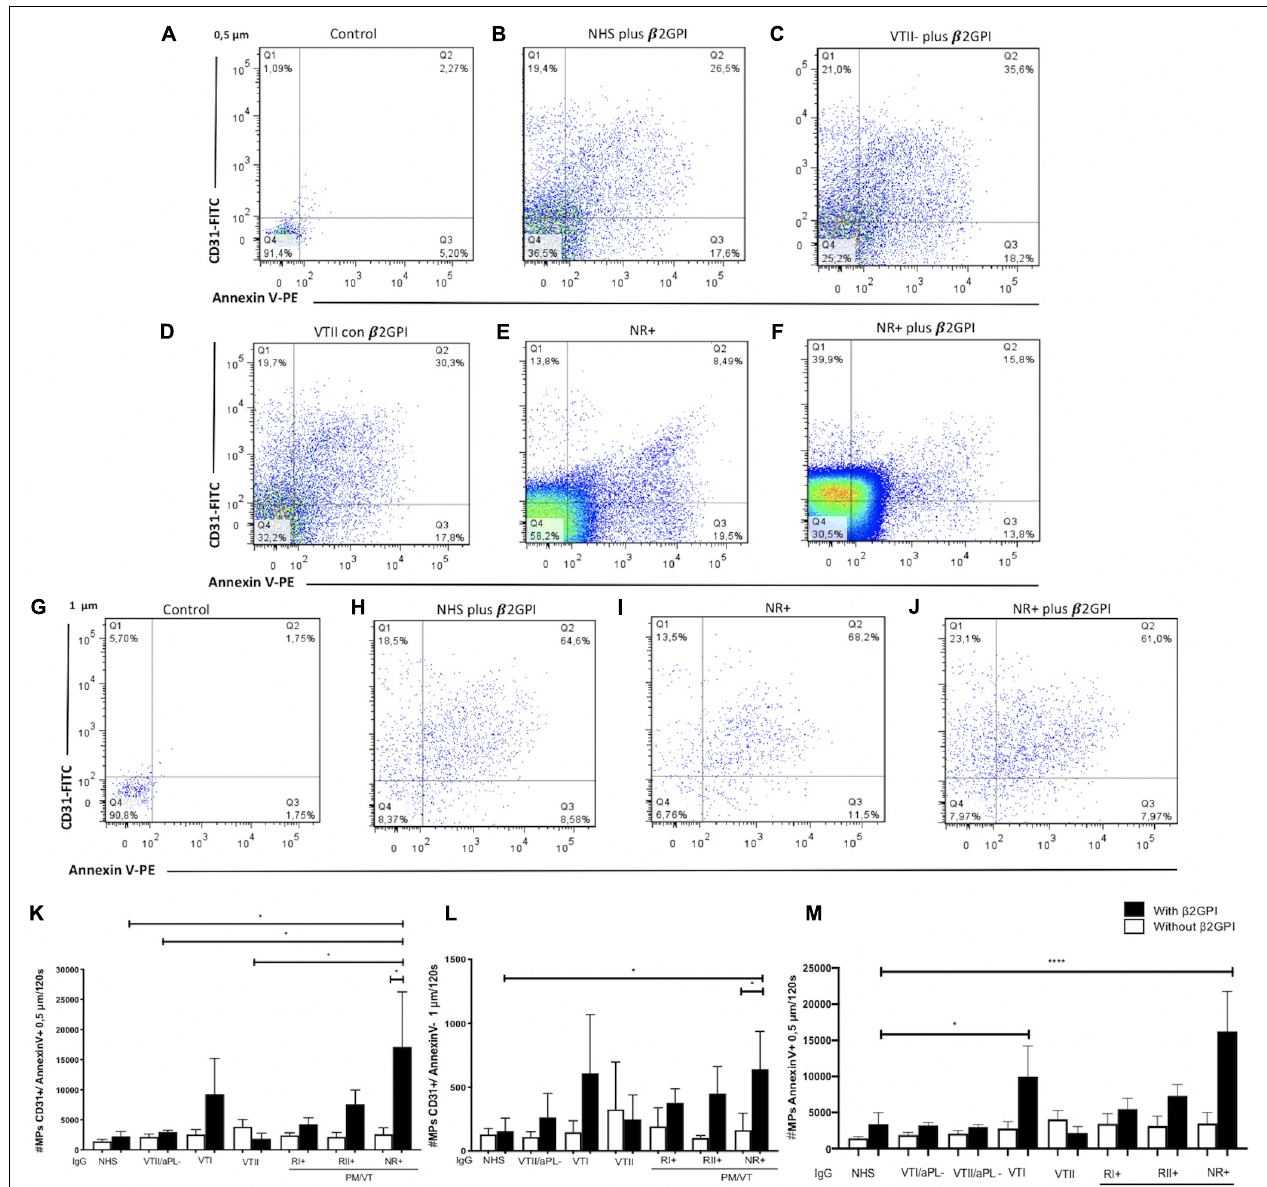
FIGURE 5 | Immunoglobulin-G from patients with non-refractory primary obstetric APS (NR+) induced the production of 0.5- and 1- µ m endothelial MPs. (A,G) Control indicates MPs without antibodies, which were used to define the location of the negative and positive MPs for Annexin V and CD31. (A–F,K) IgG/NR+ increased the number of 0.5- µ m CD31+/annexin V+ MPs in the presence of β 2GPI, compared with NHS IgG, secondary thrombotic APS (VTII)/antiphospholipid antibodies (aPL) IgG, VTII IgG, and IgG of patients with NR+ without β 2GPI. (G–J,L) IgG from patients with NR+ increased the number of MPs of 1- µ m CD31+/annexin V- in a β 2GPI-dependent manner compared with the IgG/NHS control and patients with NR+ without β 2GPI. (M) IgG from patients with VTI and NR+ increased the number of total MPs of 0.5-( µ m annexin V (in a ( β 2GPI-dependent manner more than IgG/NHS; Annexin V (MPs are the indicators